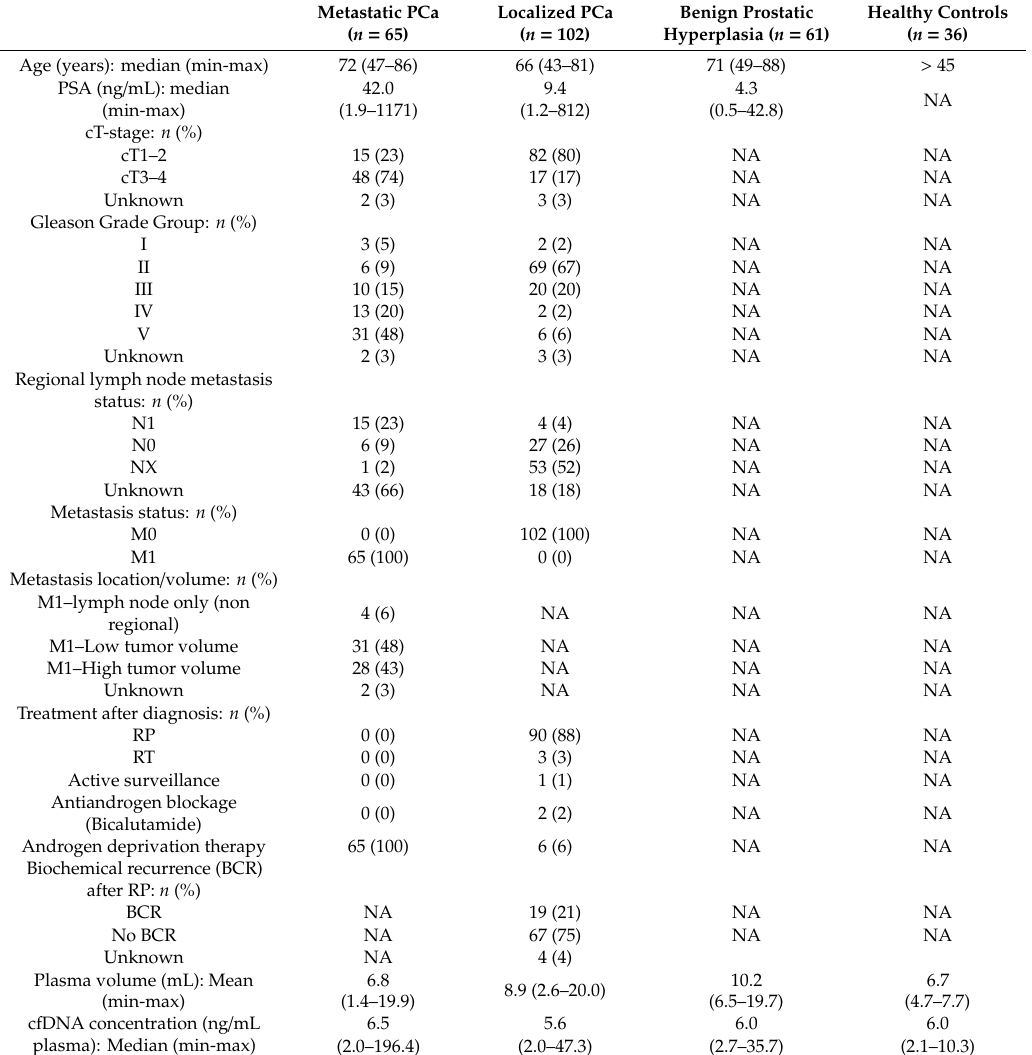
Table 1. Patient characteristics of clinical